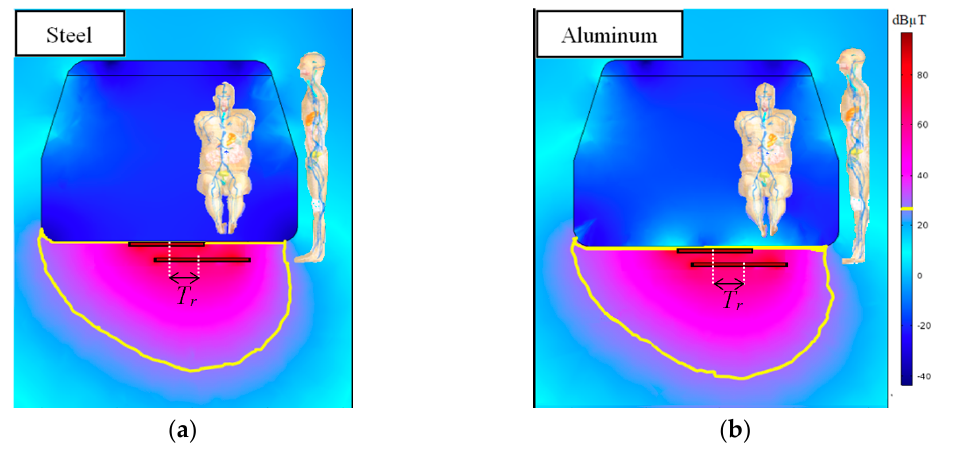
Figure 3. Magnetic flux density distribution for the misaligned coil position. ( a ) Steel chassis; ( b ) aluminum chassis. The yellow line represents the ICNIRP limit (RL = 27 µT = 28.63 dBµT).